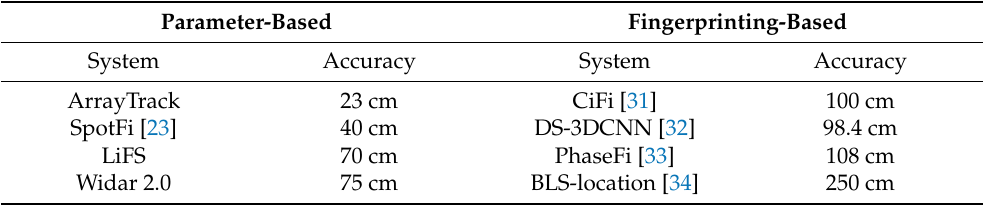
Table 1. The parameter-based vs. fingerprinting-based algorithm comparison.